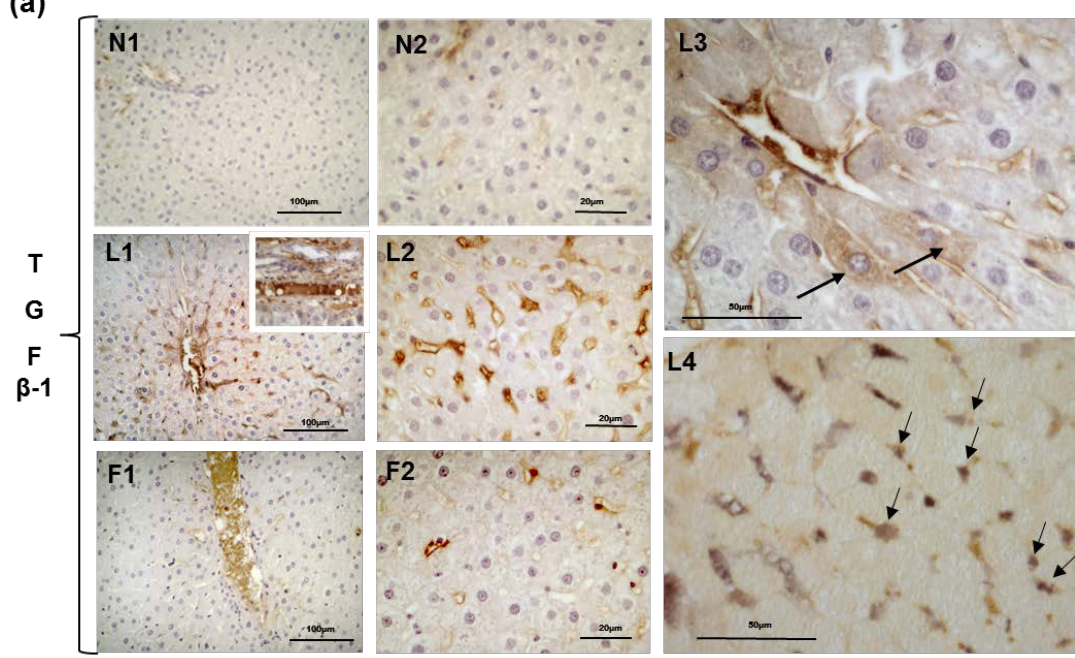
Figure 7. Immunostaining for TGFβ1 in sections from rats fed a control diet (N), high-lard diet (L) or high-fish oil diet (F). ( a ) The immunostaining for TGFβ1, in two different magnifications, was very weak and localised in the wall of a few blood vessels in the N livers. The number of TGFβ1-immunoreactive cells was increased in the L compared with the N rats, exhibiting a strong staining around the central vein. In L1-L2, the lumen of the blood vessel was filled with TGFα1-immunoreactive material (L1 insert). In L3, the cells lying along the wall of a blood vessel are heavily immunolabelled; in the parenchyma, two hepatocytes were weakly positive (arrows). L4 represents a double-immunostained section for TGFβ1 and CRBP1 indicating that most of the cells were immunoreactive to both antibodies. In the F rats, the TGFβ1-immunoreactive material was limited to the lumina of some blood vessels (F1-F2); ( b ) Representative Western blot analysis of TGFβ1. The relative levels in the N, L and F rat livers were densitometrically quantified and are expressed as the means ± SE. * p < 0.05 vs. N rats. # p < 0.05 compared with L